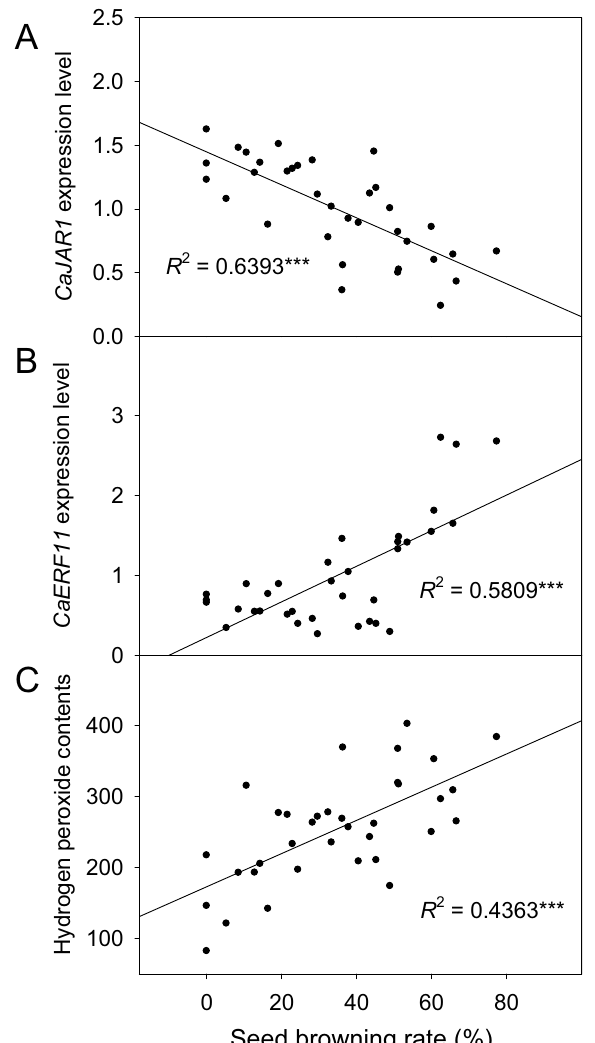
Figure 6. Correlation analysis of the seed browning rate with CaJAR1 expression level ( A ), CaERF11 expression level ( B ), and hydrogen peroxide content ( C ) in ‘ UZB-GJG-1999–51 ’, ‘ C00562 ’, and F 2 groups after chilling treatment at 2 °C for 3